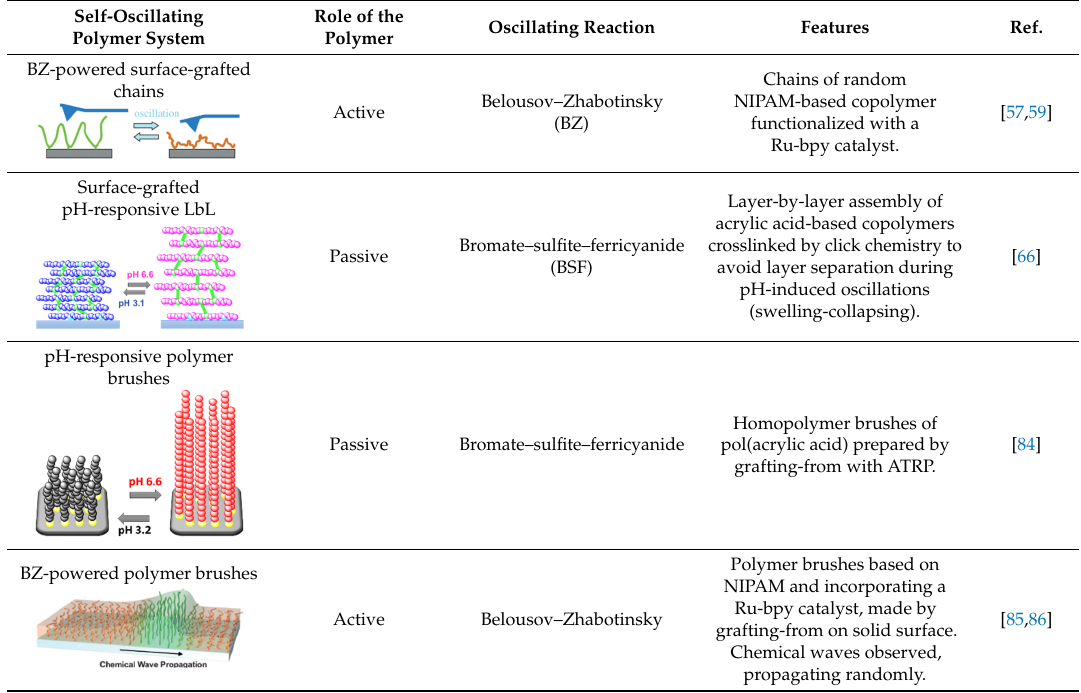
Table 1. Synopsis of the self-oscillating polymers at interfaces discussed in the present review. Self-Oscillating Polymer System